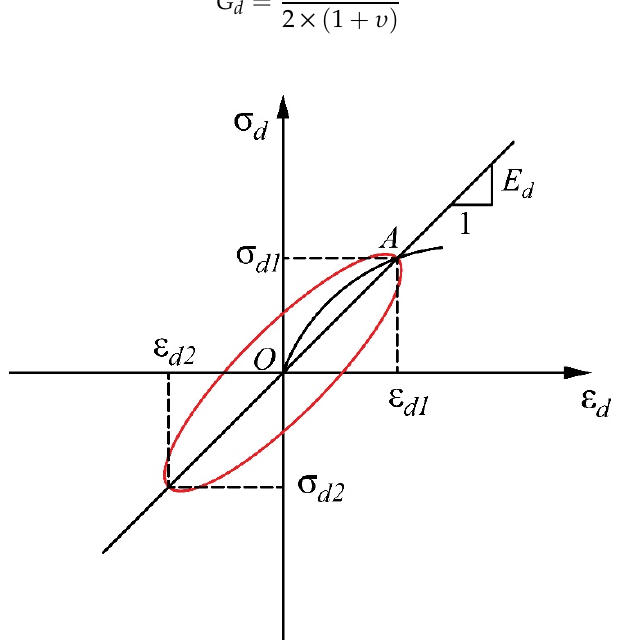
Figure 4. Stress–strain behavior of soil under cyclic axial loading and determination of dynamic elasticity modulus.